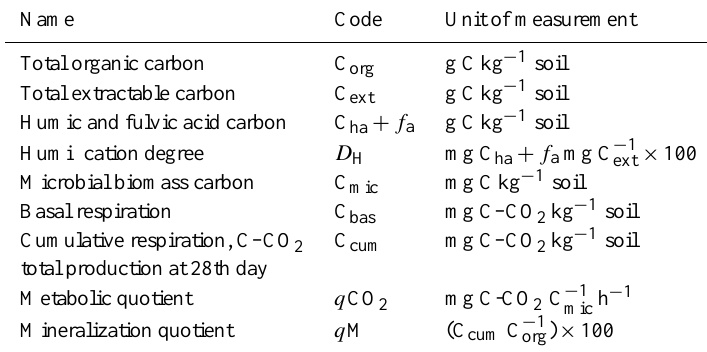
Table 4. Biochemical soil attributes.